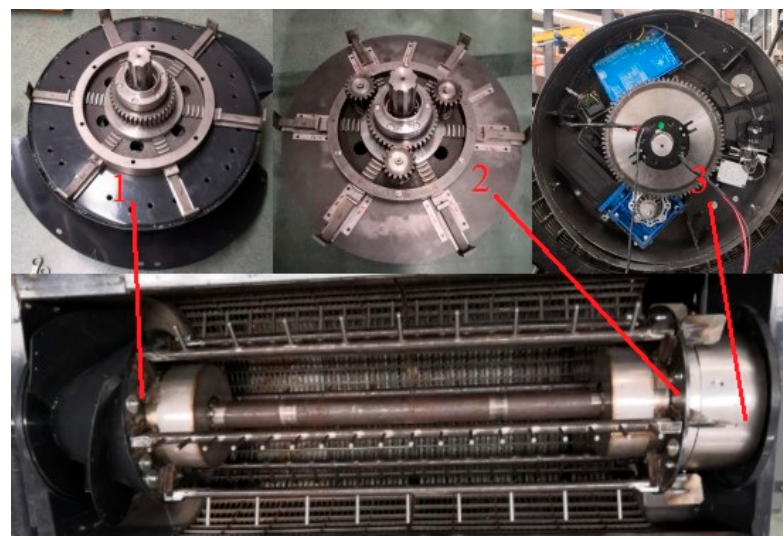
Figure 7. Real product photo for the assembled variable-diameter threshing drum, 1. Feeding wheel and adjustment device 2. Adjustment device for rear supporting wheel 3. Electronic control self-locking device.